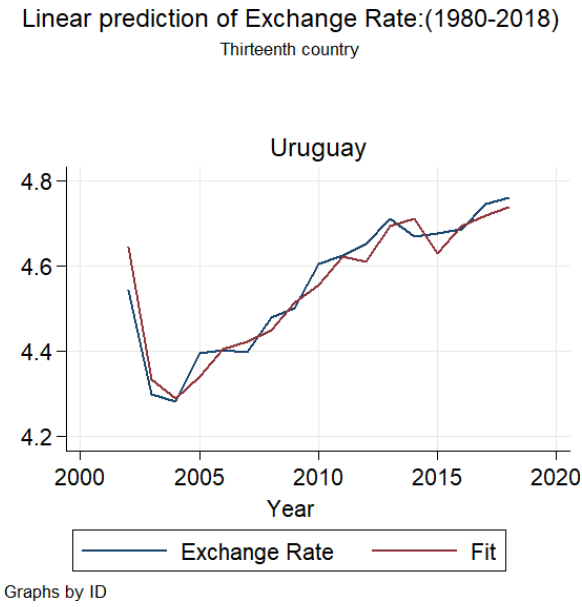
Figure3 : Linear Prediction of Exchange